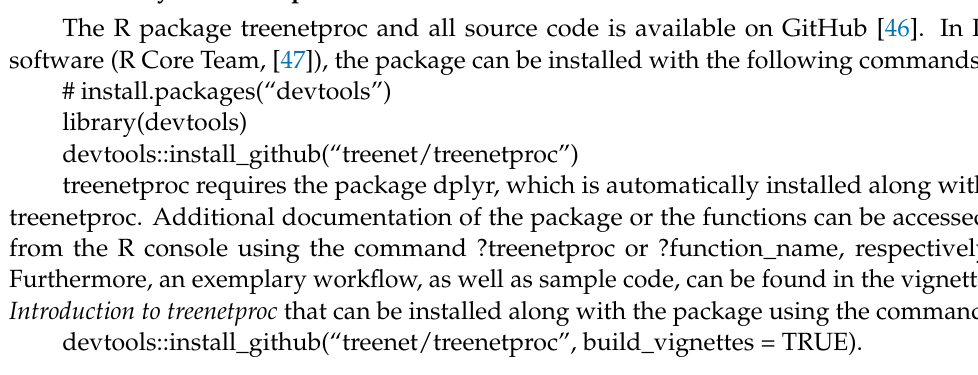
Figure S5: Calculation of shrinkage and expansion phases with phase_stats, Table S1: Input data format (long), Table S2: Input data format (wide), Table S3: Output data format of the